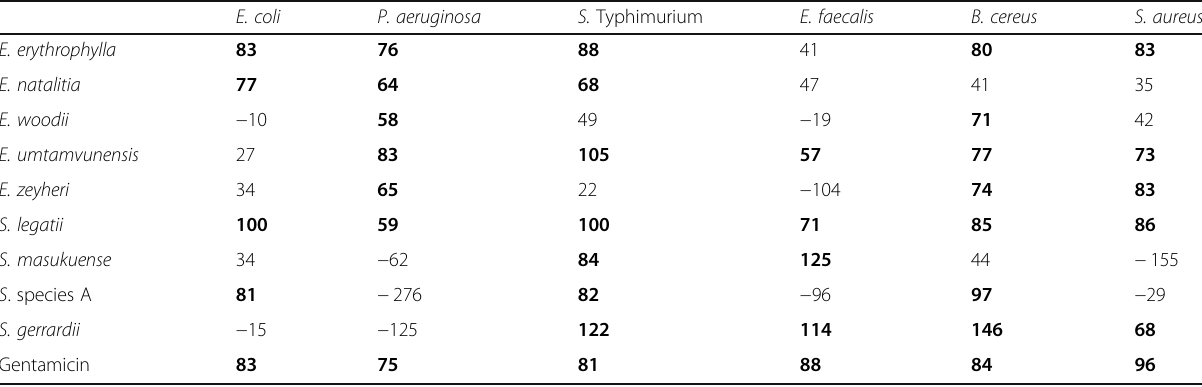
Table 4 Effect of acetone crude leaf extracts of nine plants against biofilm formation by Gram-negative and Gram-positive bacteria. Inhibition of biofilm formed is expressed as percentage ( % ) biofilm inhibition. The numbers > 0% ≥ 50% show low activity, > 50% (in bold) show high activity against the bacteria. Negative values denote enhancement of biofilm